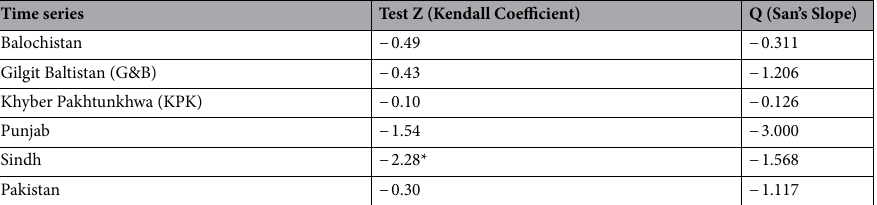
Time series Test Z (Kendall Coefficient) Q (San’s